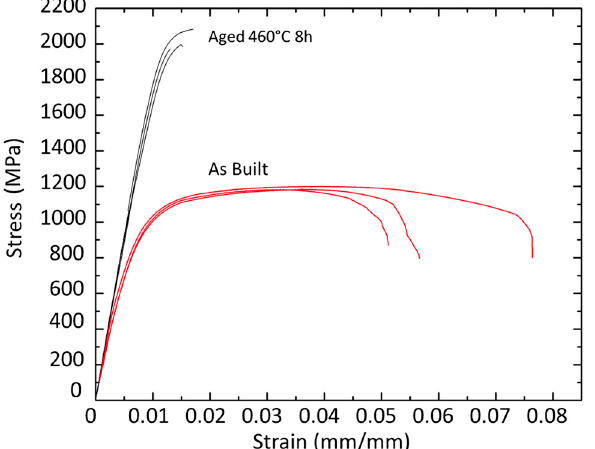
Figure 10. Tensile curves of as built and peak aged 18 ‐ Ni 300 steel.